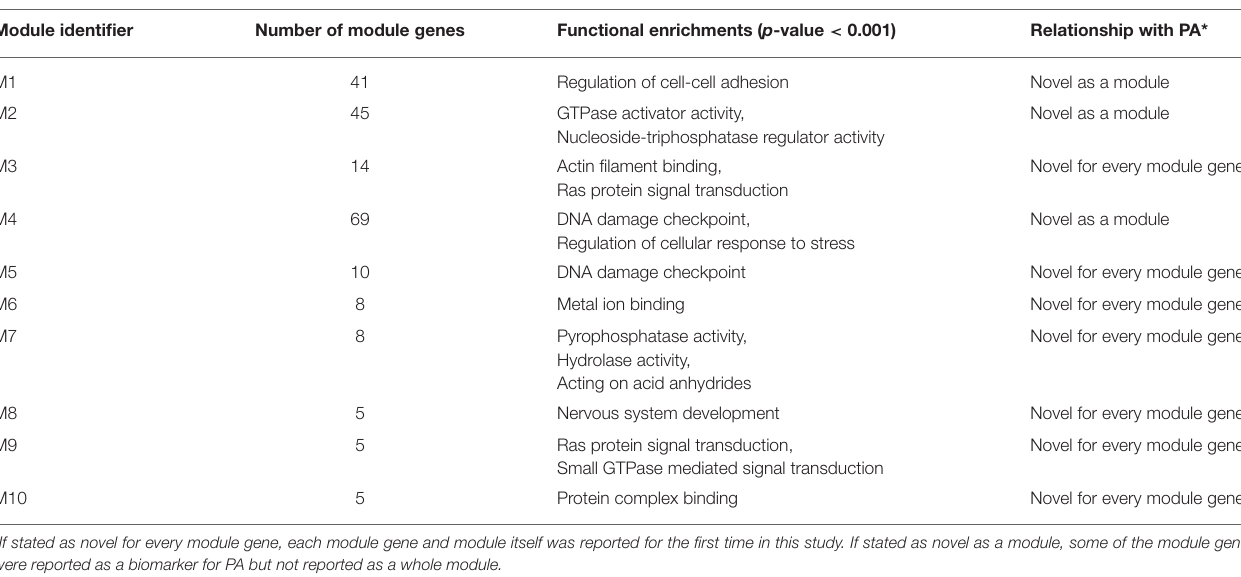
TABLE 1 | Identified modules and their features.